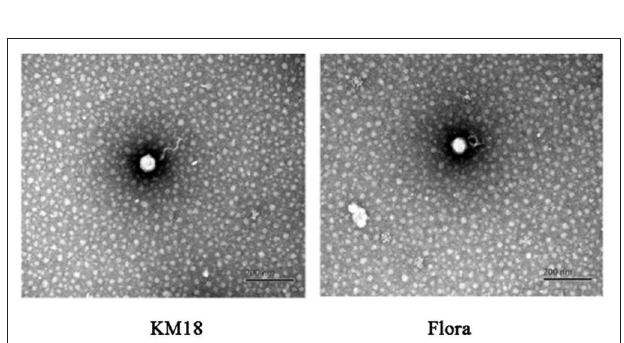
FIGURE 2 | Morphological features of E. coli phages KM18 and Flora as demonstrated by transmission electron microscopy (TEM).